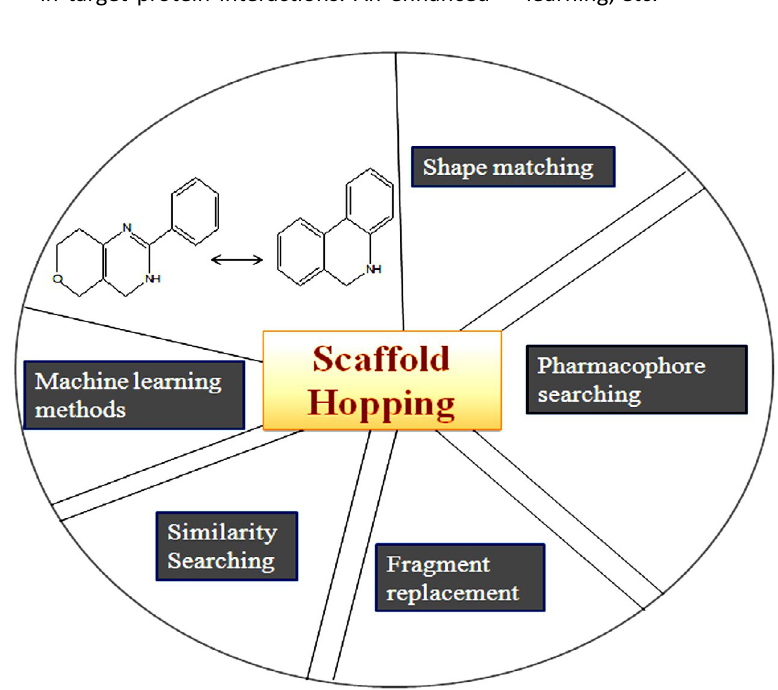
Fig. 11. Scaffold hopping: Computational